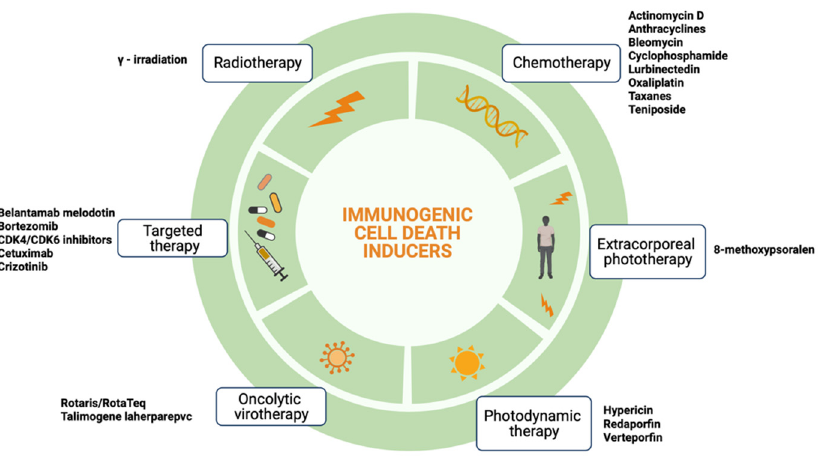
Figure 1. Immunogenic cell death inducers. Immunogenic cell death inducers can be grouped into six different categories: chemotherapy agents, radiotherapy, extracorporeal phototherapy, photodynamic therapy, oncolytic virotherapy, and targeted therapy. Table 1. Mechanism of ICD induction for selected ICD inducers.